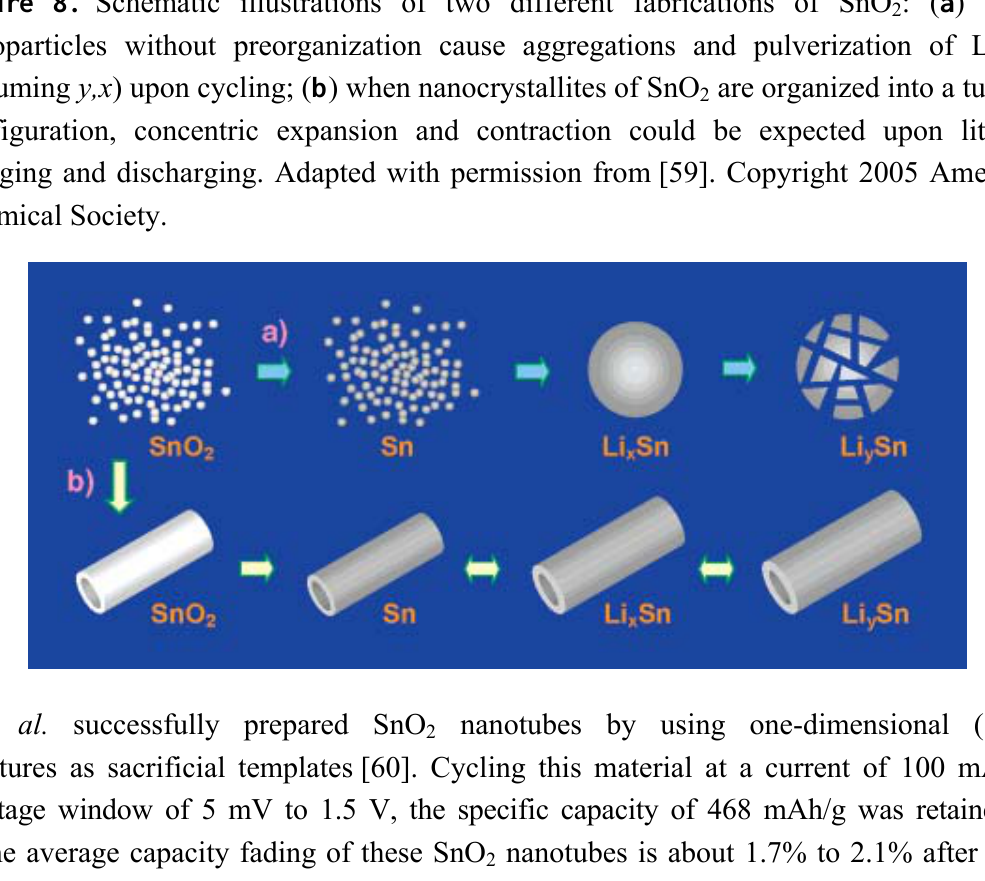
: ( a ) SnO 2 2 Sn y x are organized into a tubular 2